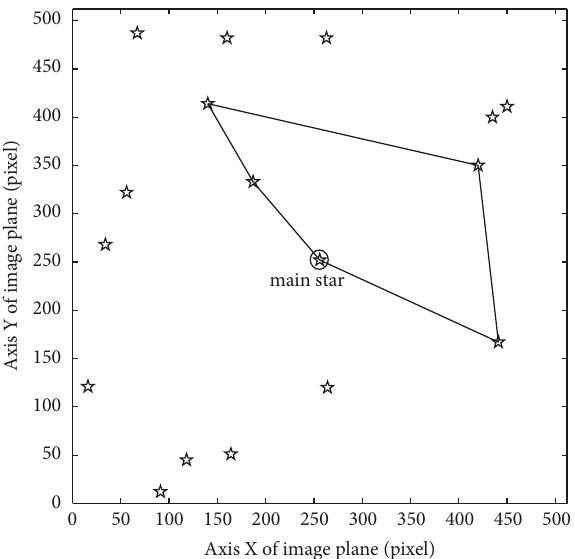
Figure 3: Optimal path in the guiding template which matches the observed